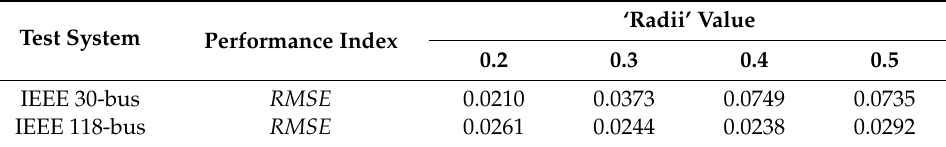
Table 5. Selection of the best ‘Radii’ value of ANFIS model.